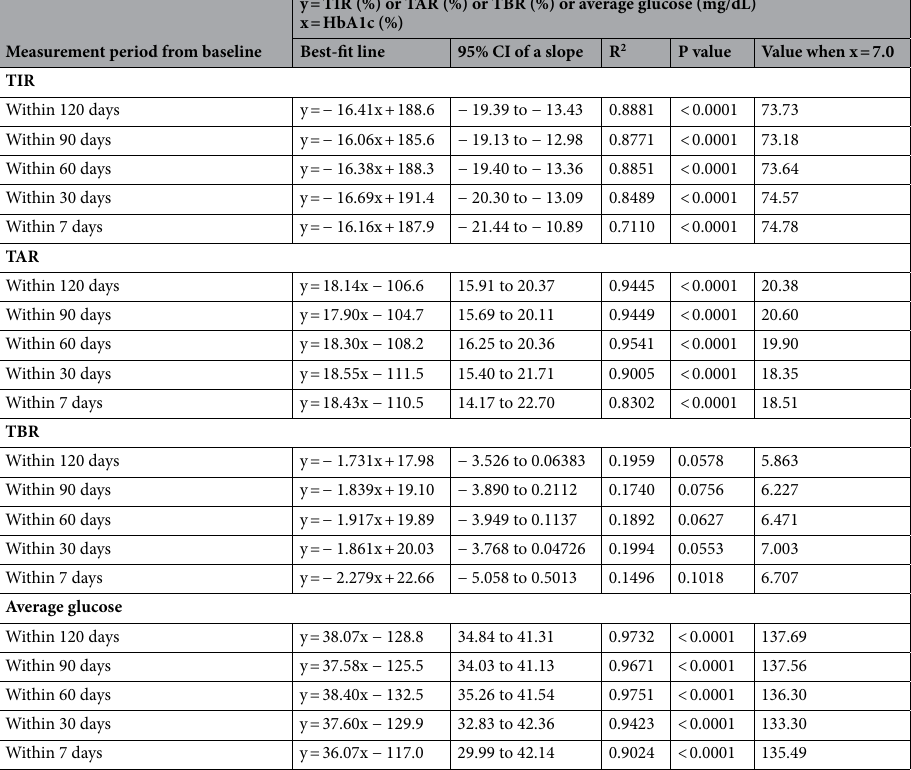
Table 1. Linear regression showing the difference in the measurement periods. TIR time in range (glucose level: 70–180 mg/dL), TAR time above range (glucose level: > 180 mg/dL), TBR time below range (glucose level: < 70 mg/dL), CI confidence interval, R 2 coefficient of determination.